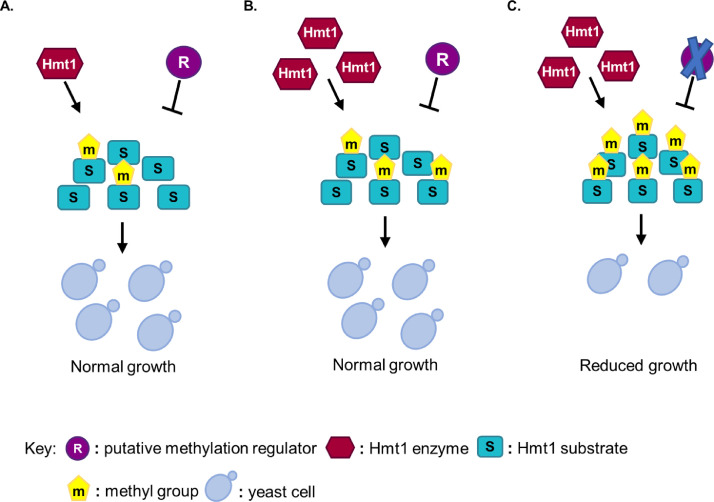
Rationale of synthetic dosage lethality (SDL) for the identification of putative arginine methylation regulators. (A) The presence of physiological levels of Hmt1 arginine methyltransferase and arginine methylation regulator (R) leads to normal growth. This putative methylation regulator could control the activity of the Hmt1 enzyme or methylation of its substrate(s) or any other step during the methylation/demethylation process. (B) Overexpression of Hmt1 arginine methyltransferase does not lead to a severe phenotype as its activity is antagonised by an intact regulator (demethylase, PRMT-regulator, modification crosstalk). General levels of arginine methylation on substrates (S) are maintained at physiological levels or increased at a tolerable level for the cells. (C) Combination of Hmt1 methyltransferase overexpression with deletion or inactivation of an arginine methylation regulator (R) results in reduced growth due to toxic hypermethylation of substrate(s). At least 30% reduction in growth would indicate an SDL interaction between Hmt1 and the putative regulator.